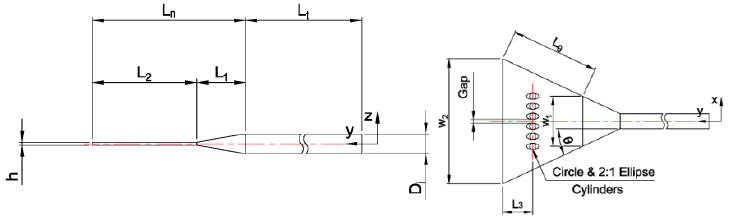
Figure 1. Analysis model of diffuser: side and planform view.